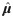
Estimates of μ^ (top) and σ^2 (bottom) from 100 realizations with n, m = 10, 100, and 1000.The horizontal lines indicate the true values of μ and σ2.